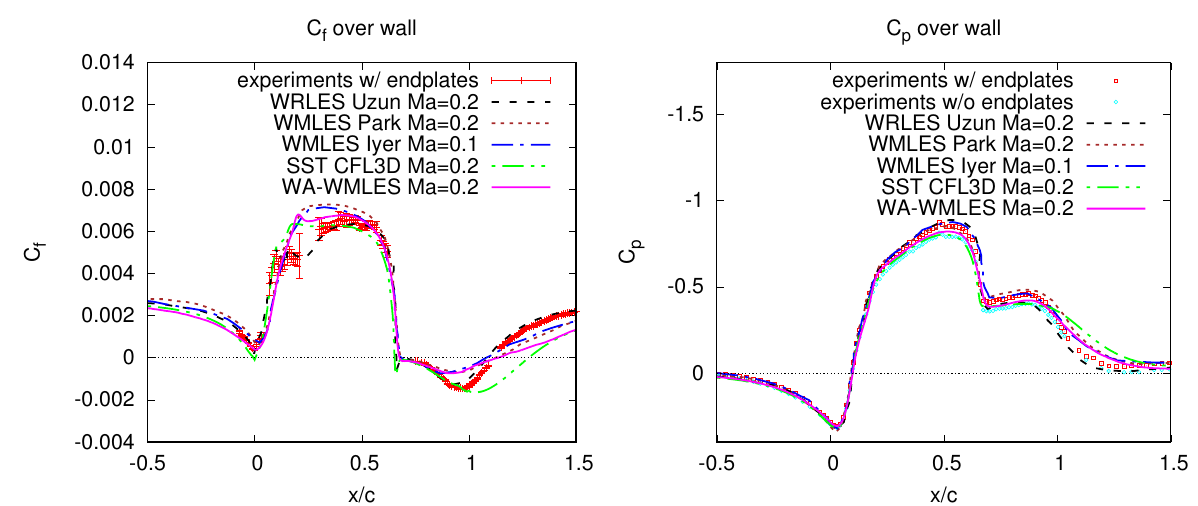
Figure 16. WA-WMLES of NASA hump flow: time and spanwise averaged skin friction ( left ) and pressure ( right ) coefficients over the wall.